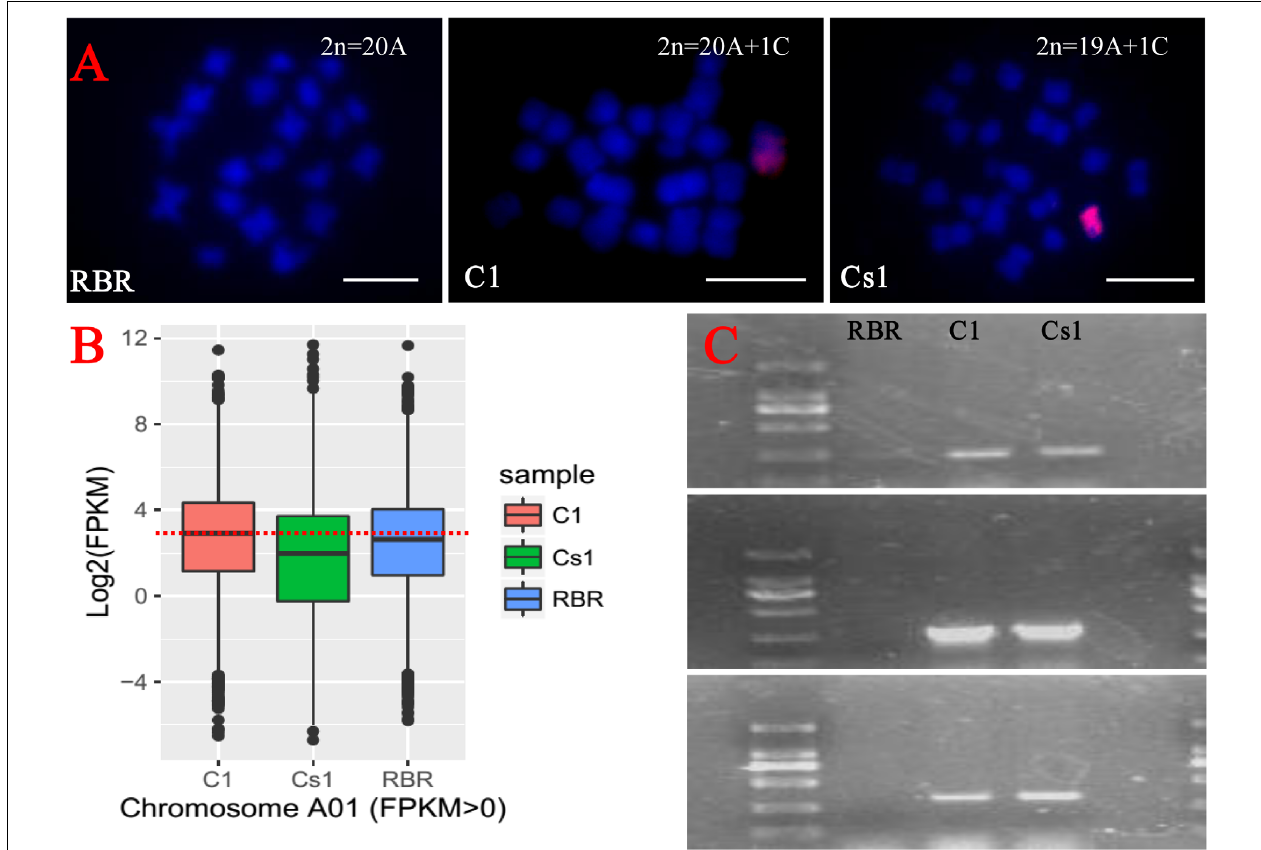
FIGURE 2 | Detection of the identity of the substitution line from the backcrossing between MAAL C1 and RBR Oro by FISH, PCR amplification and RNA-seq analysis. (A) Blue color is for DAPI staining and red signal is from the labeled BAC BoB014O06 probe. The FISH analysis shows a chromosome configuration from mitotic cell with 19A chromosomes and 1C chromosome in substitution line. Bar: 10 µ m. (B) Box plot of Log 2 (FPKM) of the total expressed genes (FPKM > 0) along on chromosome A1 indicates one A1 chromosome missing. (C) PCR amplifications of C1 chromosome specific gene markers confirms that the C1 chromosome retains in the substitution line. The sizes of marker ladder from top to end are 2000, 1000, 750, 500, 250, and 100 bp,